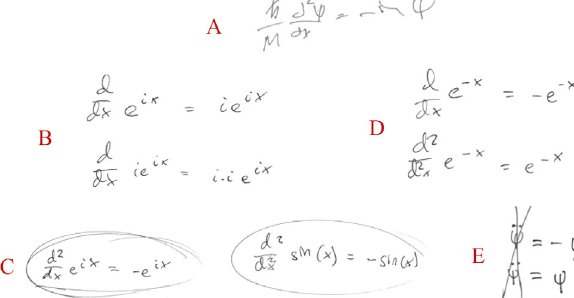
FIG. 11. Student work by Penny and Morgan. The letters show the order in which this work was written and are used for reference in the